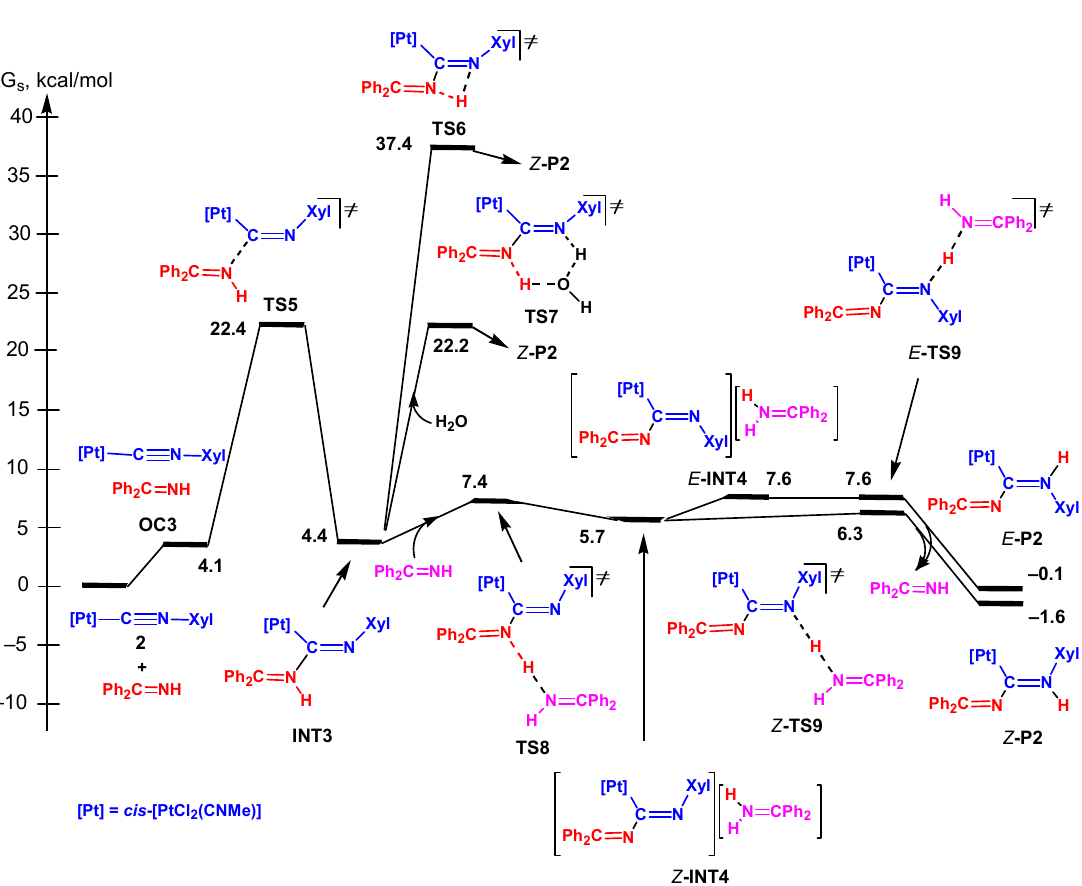
Figure 4. Energy profile for the associative mechanism of nucleophilic addition of HN=CPh 2 to the C ≡ NXyl ligand in cis -[PtCl 2 (C ≡ NMe)(C ≡ NXyl)].